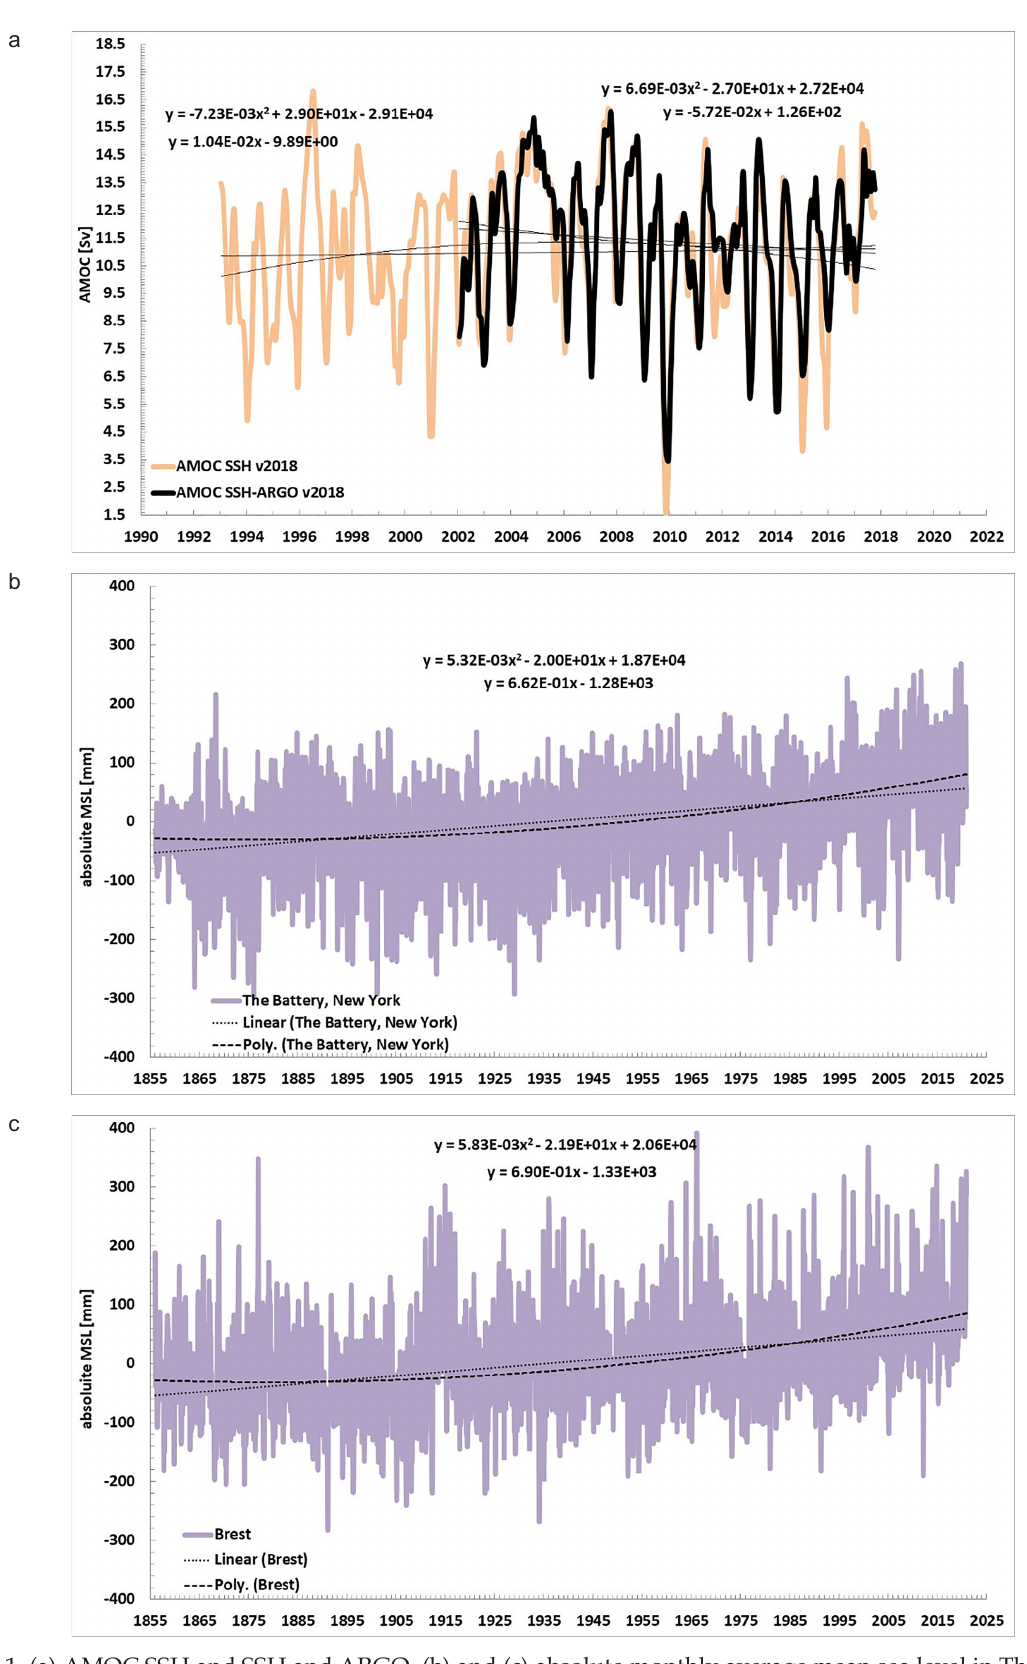
Fig. 1. (a) AMOC SSH and SSH and ARGO. (b) and (c) absolute monthly average mean sea level in The Battery, New York, and